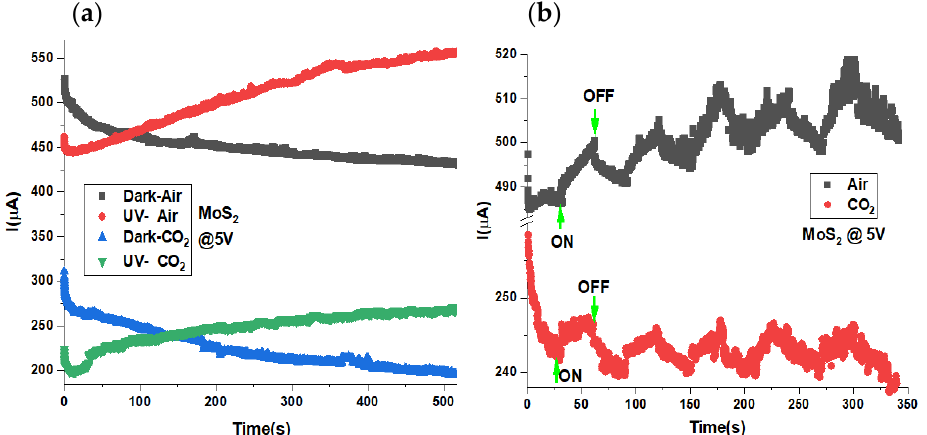
Figure 10. ( a , b ) Photocurrent behavior with time and on–off time-resolved photoresponse of MoS 2 thin film under dark and UV illumination conditions in both air and 50 sccm CO 2 environments at a bias voltage of 5 V. On the other hand, for WS 2 , we observed a better response than MoS 2 thin film. We measured the electrical IV properties of WS 2 thin film under dark and UV illuminations 11a. We observed a better response under light illumination in both positive and negative